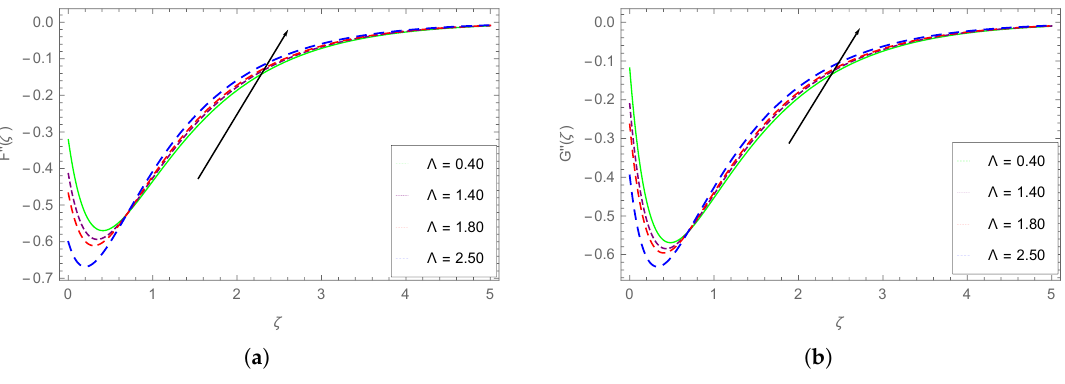
Figure 9. Impact of Λ on the shear stress profiles ( a ) F (cid:48)(cid:48) ( ζ ) and ( b ) G (cid:48)(cid:48) ( ζ ) . The impact of the Grashof number Gr (1.0, 3.0, 5.0, 7.0) on F ( ζ ) and G ( ζ ) profiles is plotted